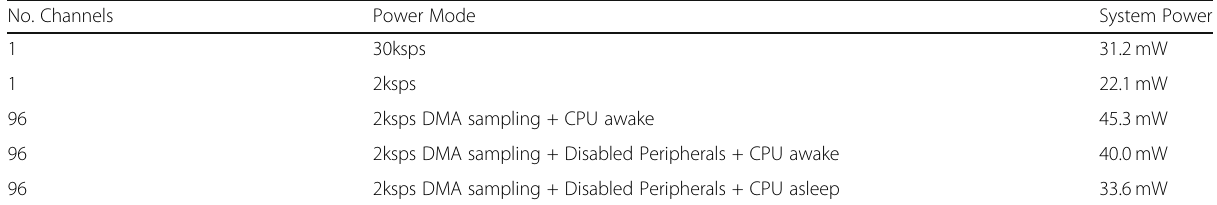
Table 2 Power Saving Techniques No.